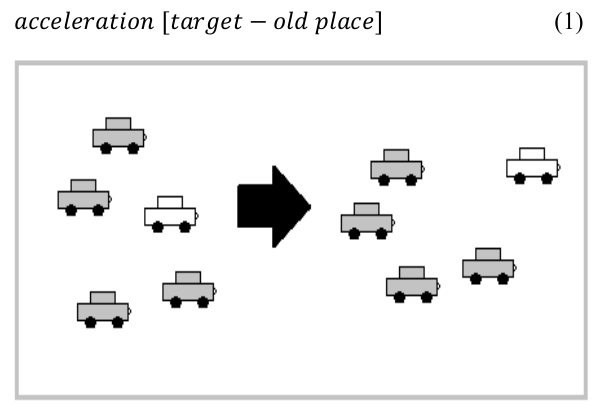
Figure 5. An Example of a Pursue Mobility Model